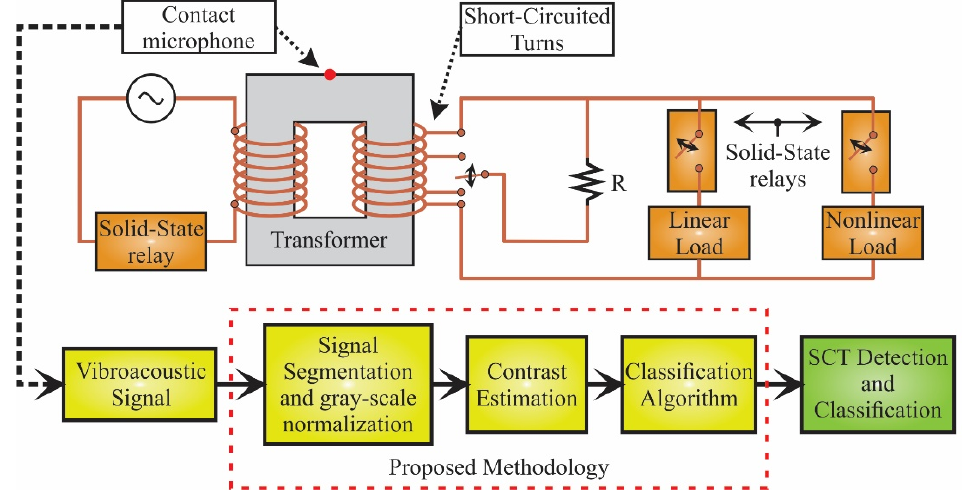
Figure 2. Flowchart for the proposed methodology.